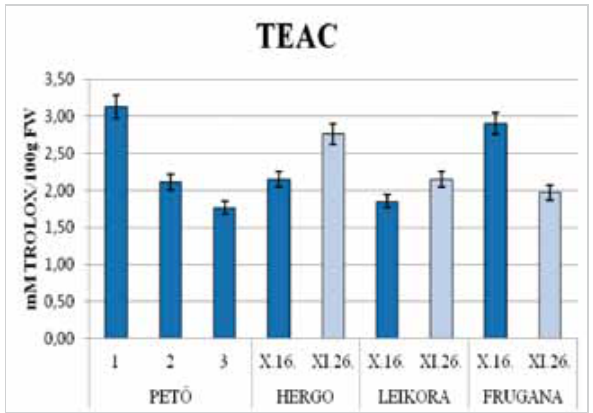
Figure 3. Antiradical capacity (TEAC assay) in sea buckthorn berries according to genotypes and harvest